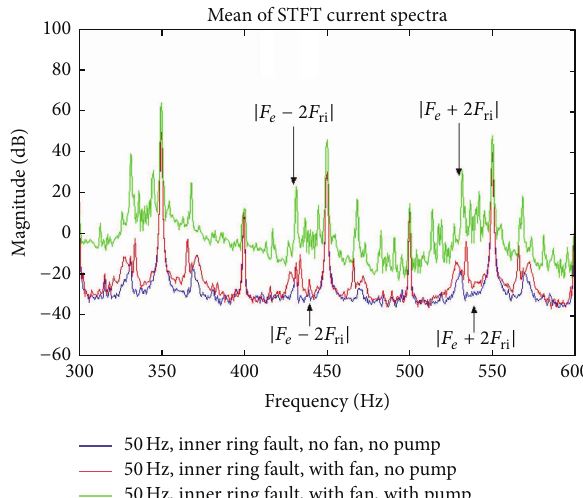
Figure 15: Generalized roughness spectra of 50 Hz motor input, the pump load condition, radial vibration measurements, and sample segments with one-hour interval.